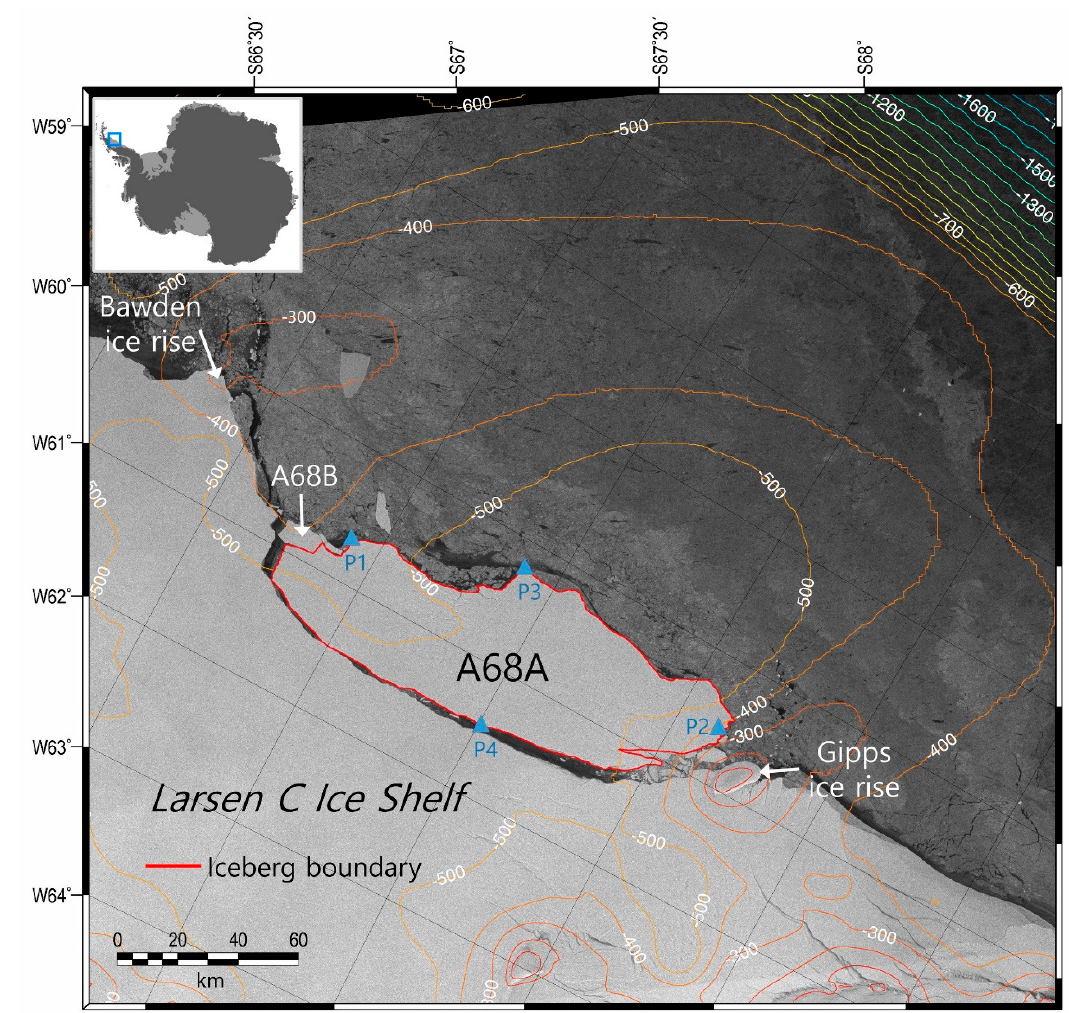
Figure 1. Sentinel-1A synthetic aperture radar (SAR) image for the study area (rectangle in the inset) obtained on 28 July 2017 overlaid with contour of seafloor from Bedmap2 in the polar stereographic projection. Points P1, P2, P3, and P4 on the edges of the iceberg have hardly show any calving. Drift speed and rotation of the iceberg were calculated at P1 and P2. The stretching rates of the iceberg were measured along the straight lines connecting the points P1 and P2, and P3 and P4, respectively.